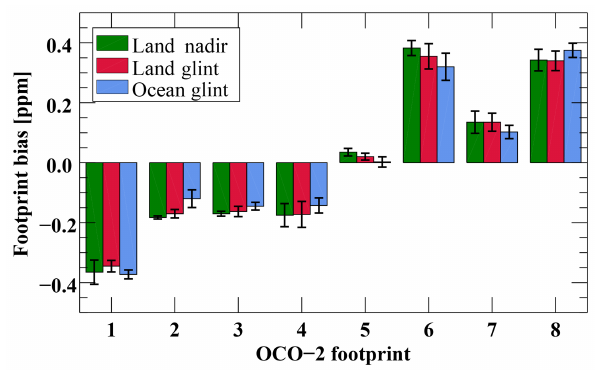
Figure 15. Estimates of the OCO-2 footprint biases, estimated sep- arately for each observing mode and surface type. Because of their similarity, a single set of biases was used in the end.